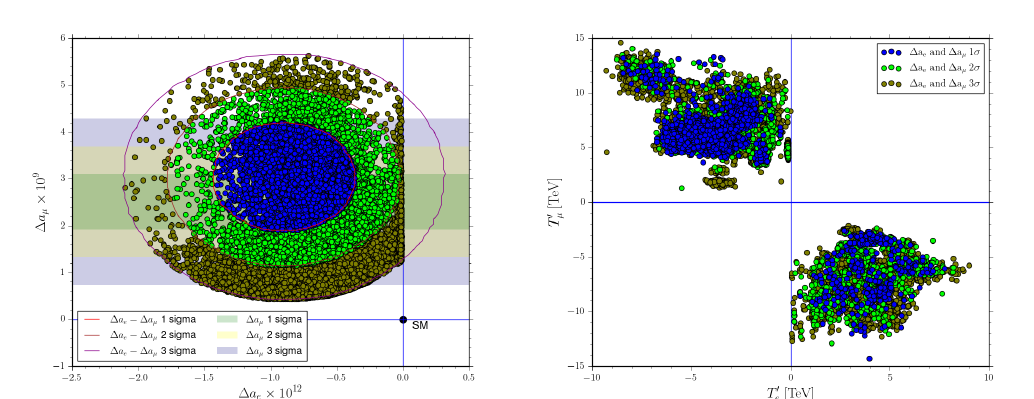
Figure 1 . Left: parameter space points where ∆ a µ and ∆ a e are within 1 σ (blue circles), 2 σ (green circles) and 3 σ (olive green circles) of their experimental values; Right: anomalous magnetic moments dependence on the non-holomorphic couplings T 0